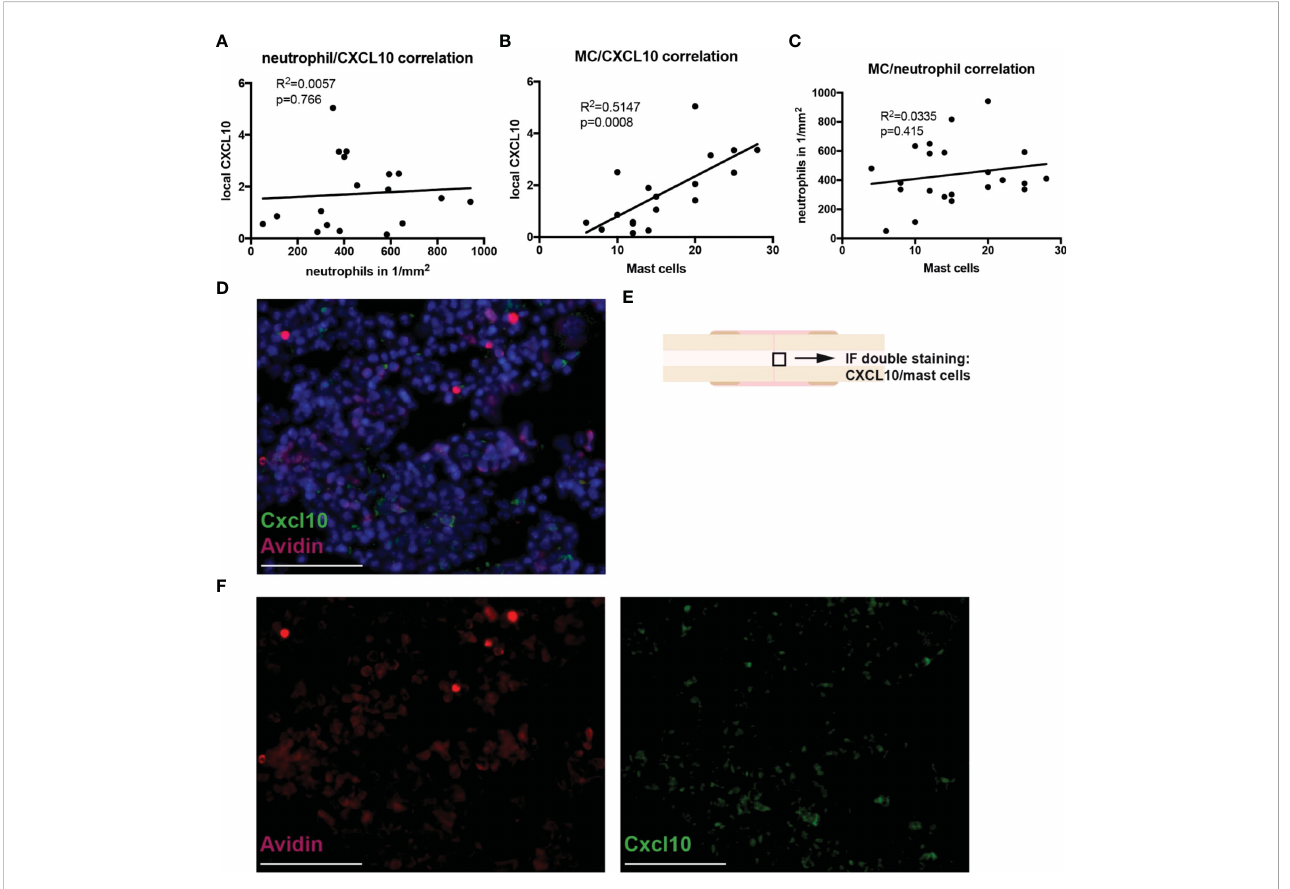
FIGURE 4 Correlations between neutrophil/mast cell numbers and CXCL10 expression in the fracture hematoma during the early in fl ammatory phase. Correlation analysis by simple linear regression was performed between the parameters neutrophil numbers, mast cell numbers and local CXCL10 protein expression in all samples. (A) Neutrophil number/CXCL10 correlation. (B) Mast cell number/CXCL10 correlation. (C) Mast cell number/neutrophil number correlation. (D) Immuno fl uoresence double staining for mast cells (Avidin staining, red) and CXCL10 (green). DNA was counterstained with Hoechst (blue). Scale bar = 50 µm. E) Black box marked the area which is shown in (E). (F) Single fl uorescent channels for Avidin (red) and CXCL10 (green). Scale bar = 50